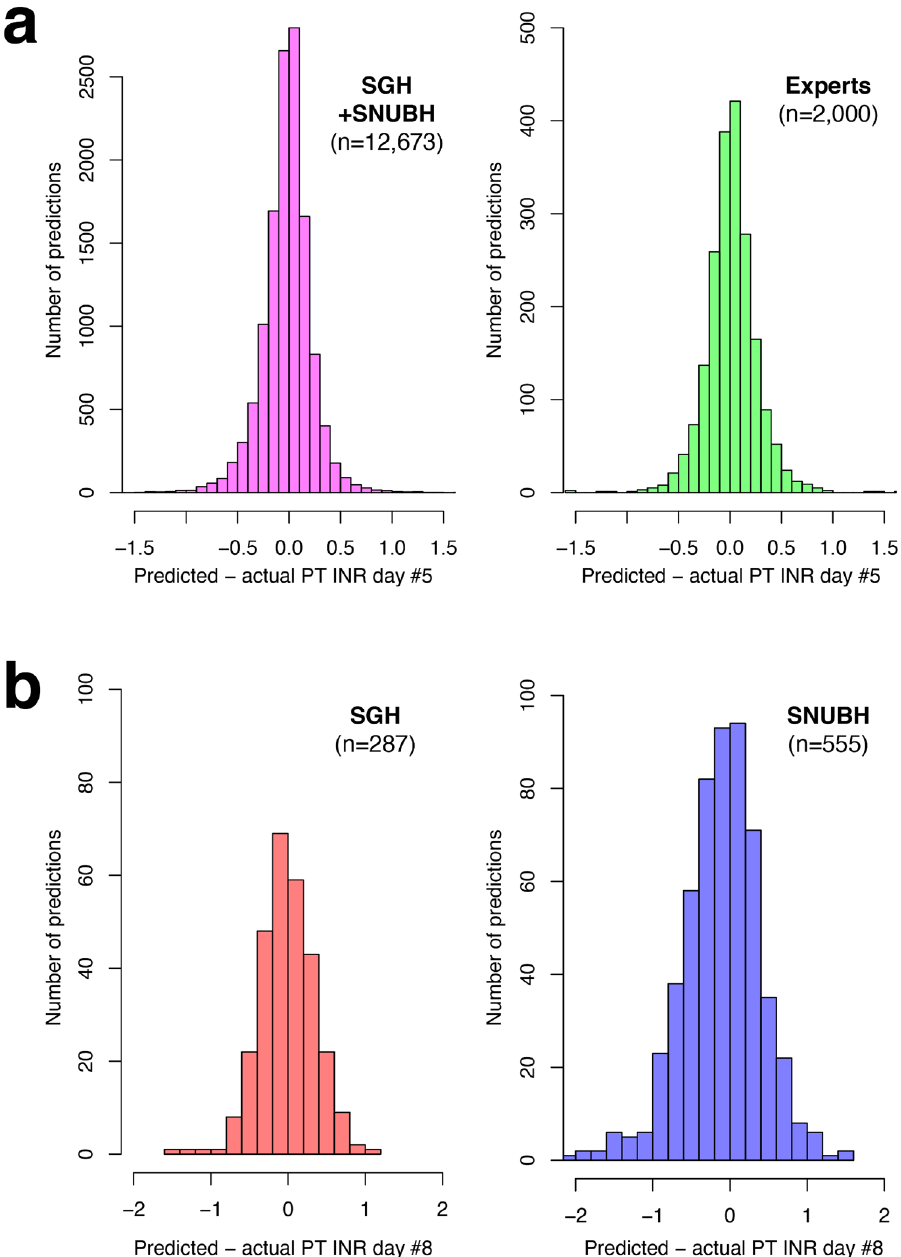
Figure 6. Distribution differences between predicted and actual prothrombin time international normalized ratios (PT INR). ( a ) The predicted 5th-day PT INR based on data from days 1–4. ( b ) The predicted 8th-day PT INR was based on data from days 1–4 and the assumption that fixed doses of warfarin were administered. SGH Sejong General Hospital, SNUBH Seoul National University Bundang